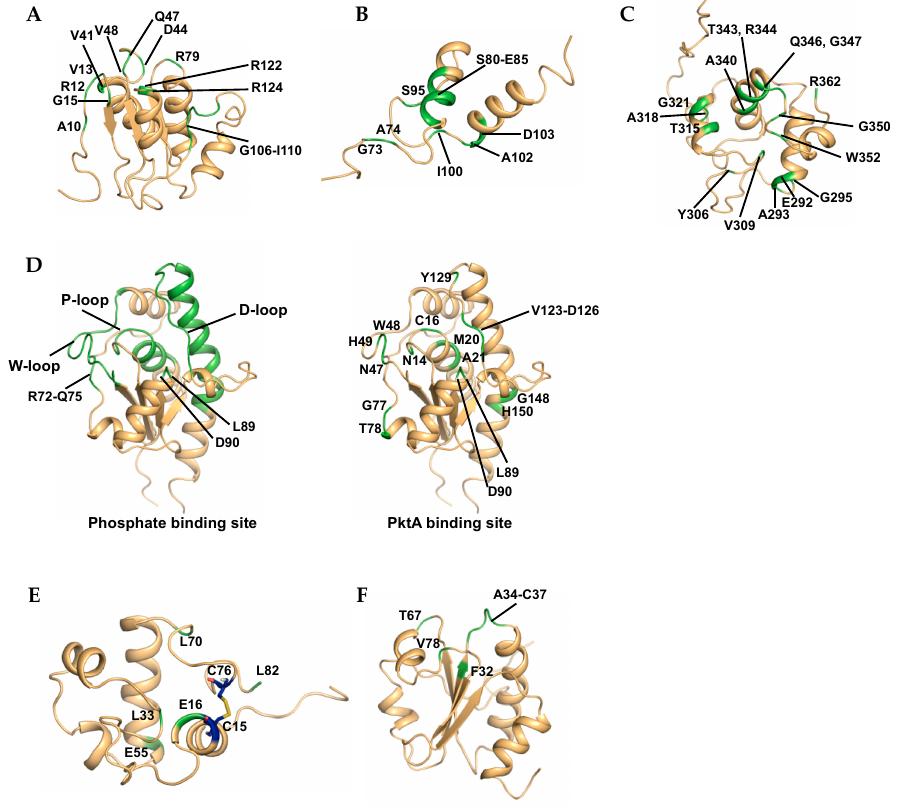
Figure 3. The mapping of the binding and conformational change sites on the ribbon representation of M . tuberculosis proteins. ( A ) GDP binding site of Rv1739c (PDB ID 2KLN); ( B ) DNA binding site of Rv3597c (PDB ID 2KNG); ( C ) tri-NAG binding site of Rv1009 (PDB ID 1XSF); ( D ) Phosphate binding site (Left) and PktA binding site (Right) of Rv2234 (PDB ID 2LUO); ( E ) Conformational change site by pH of Rv1884c (PDB ID 2N5Z); ( F ) TrxR binding site of Rv3914 (PDB ID 2L59). The residues showing significant chemical shift changes are labeled and colored in green. The disulfide bond is represented in blue color.